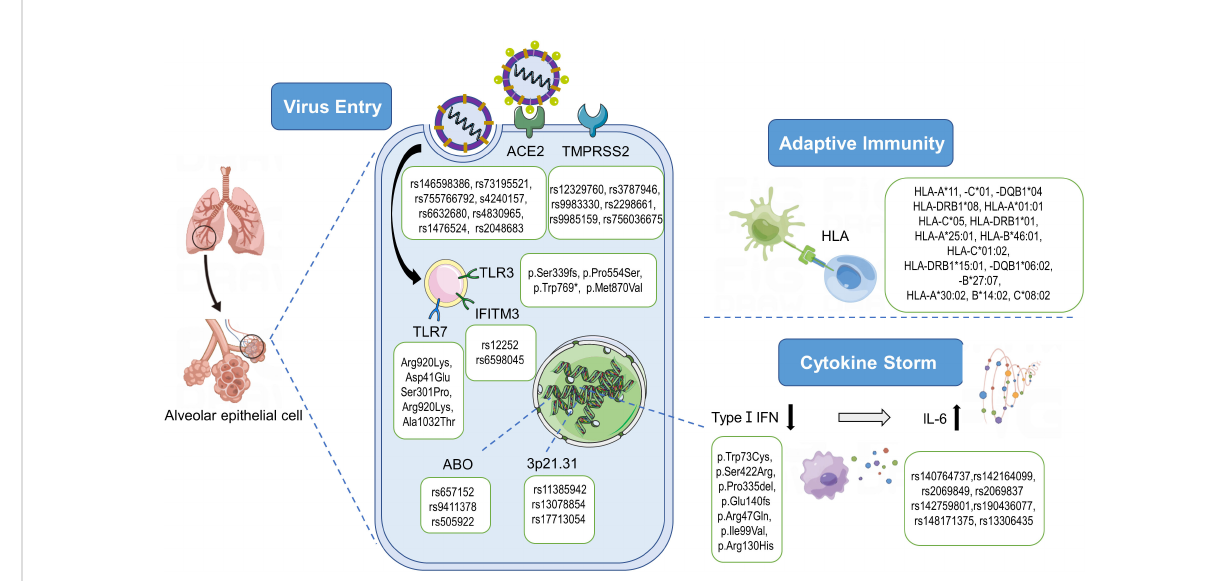
FIGURE 2 Pathogenesis of SARS-CoV-2 and genetic variants associated with severe COVID-19. After the recognition of ACE2 and the priming by TMPRSS2, SARS-CoV-2 enters the cell and starts the replication process. The innate immune response signaling cascade starts with the recognition of pathogen ‐ associated molecular patterns (PAMPs) by endosomal toll ‐ like receptors (TLRs). SARS-CoV-2 is able to inhibit the type I IFN responses in infected cells, leading to the cytokine storm characterized by an increase of in fl ammatory cytokines/chemokines such as IL-6. As an antiviral mechanism, antigen-presenting cells present antigenic peptides through the Major Histocompatibility Complex (MHC) class I and class II molecules to T cells. And 3p21.31 and ABO loci are signi fi cantly associated with Covid ‐ 19 severity. ACE2, angiotensin ‐ converting enzyme ‐ 2; TMPRSS2, transmembrane serine protease ‐ 2; HLA, human leukocyte antigen; IFN, interferon; TLR, Toll-like receptor 7; IFITM3, interferon induced transmembrane protein 3; IL, Interleukin. By Figdraw (www. fi